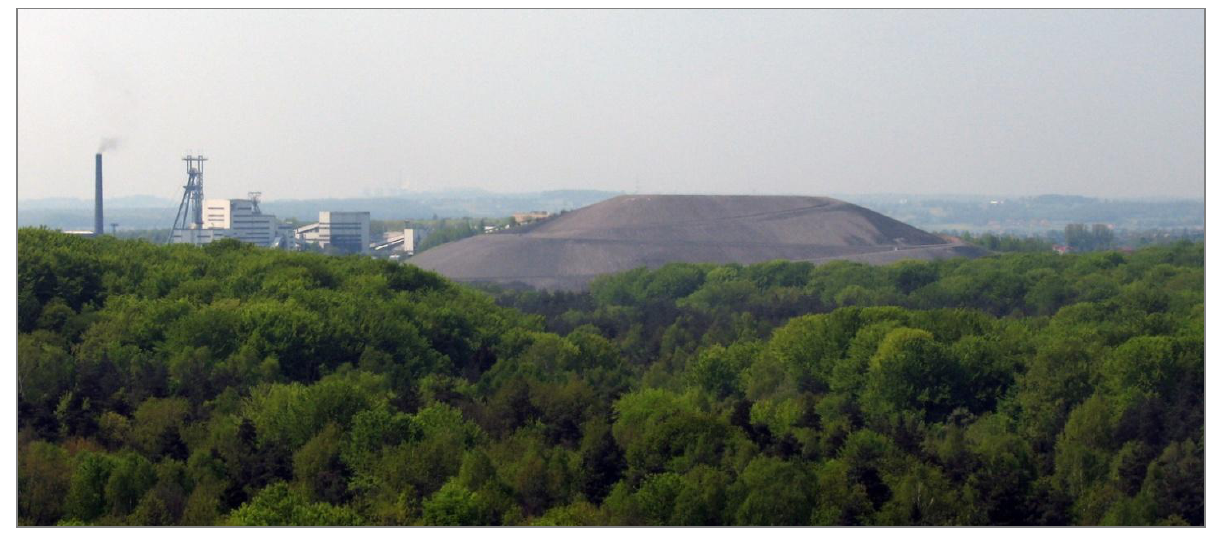
Fig. 3. “Murcki” Coal Mine and post-exploitation areas ( J. Nita